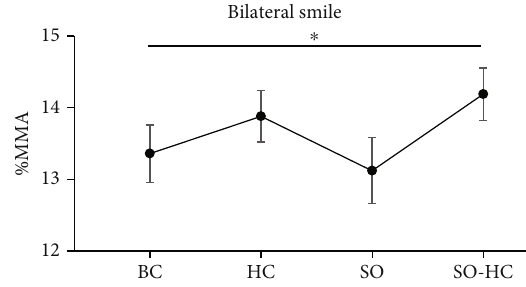
Figure 6: The graph shows the results of the bilateral task in both acquisitions considering the FIT-SAT conditions. Speci fi cally, %MMA (the maximum Euclidian distance in millimeters between the two lip corner markers) increased in SO-HC (smile observation and hand contraction) with respect to the baseline (BC). Error bars represent SE (standard errors of the means).